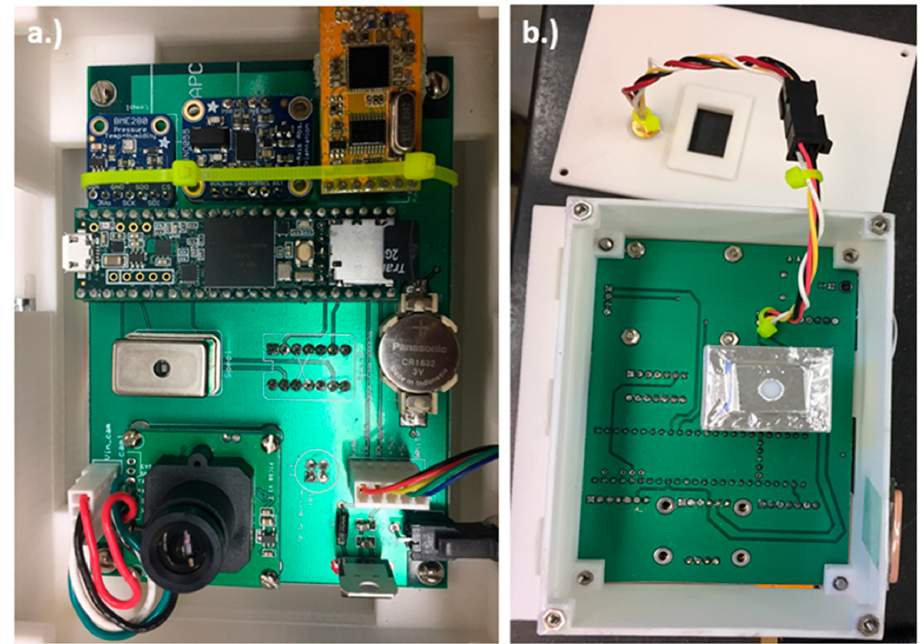
Figure 2. Albedometer components: ( a ) Top view of printed circuit board including components (from left to right, top to bottom): BME280 temperature sensor, BNO055 absolute orient, APC220 radio, Teensy 3.6 microcontroller, C12666MA micro-spectrometer, Back-up battery, VC0706 camera, UBX-G7020 GPS; ( b ) Bottom view of printed circuit board including the C12666MA spectrometer with diffuser and MLX90614 infra-red (IR) sensor.